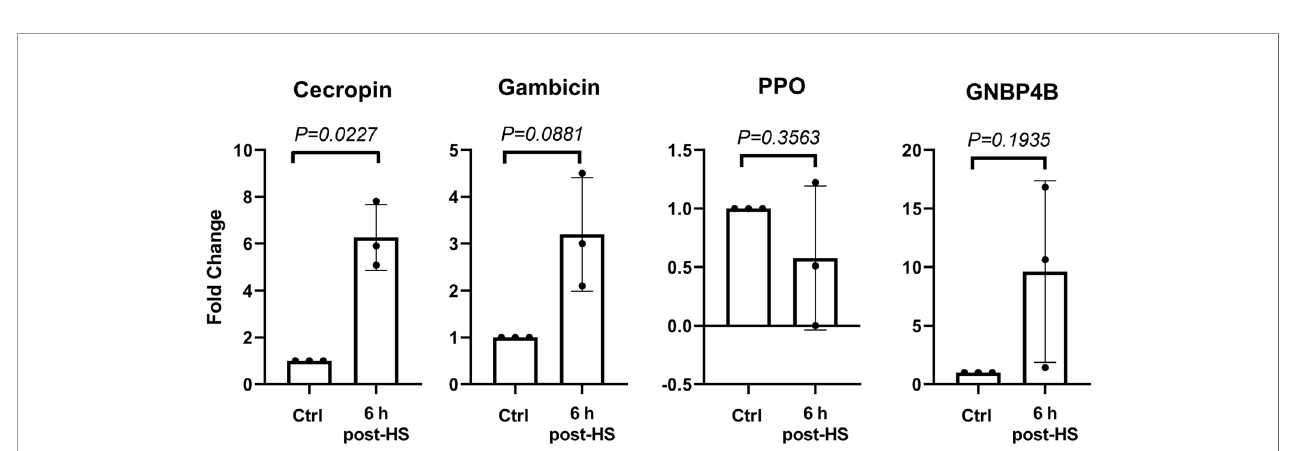
FIGURE 5 | Gene expression at 6 h post heat shock in midguts. Gene expression was evaluated at 6 h after 30 min of exposure at 37°C (heat shock-HS) in midguts. Data of three independent experiments were analyzed using unpaired t test with Welch ’ s correction. Data are indicated as mean ± SD. Cecropin 6.2 ± 1.4, Gambicin 3.2 ± 1.2, PPO 0.5 ± 0.6, and GNBP4B 9.6 ±